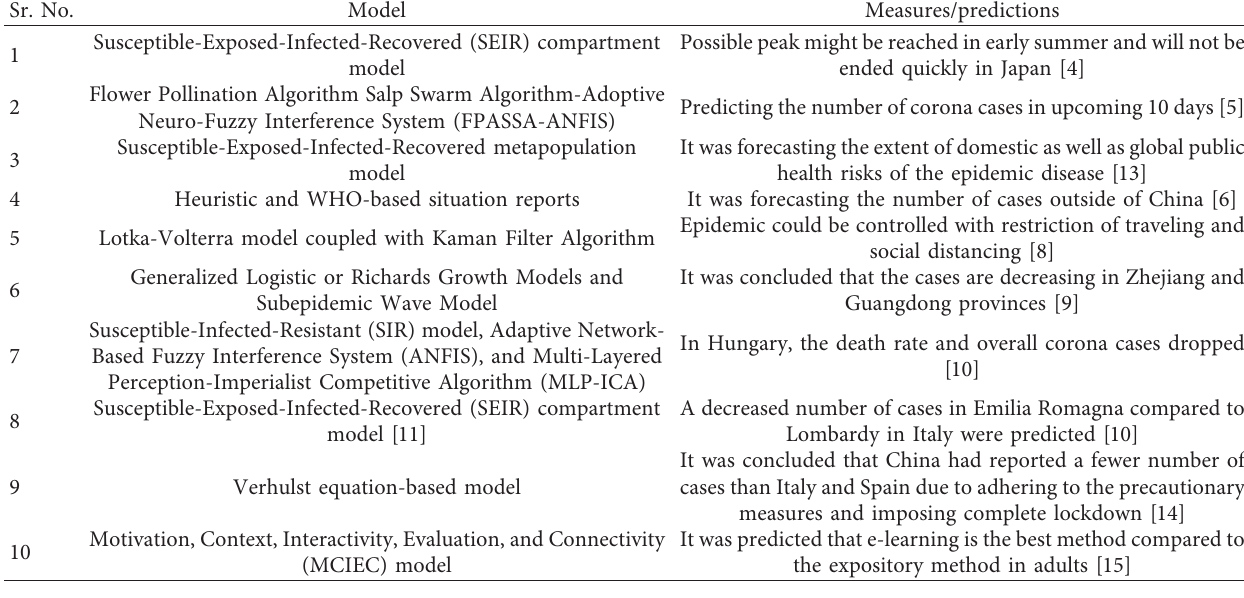
Table 1: Previous studies model and targeted